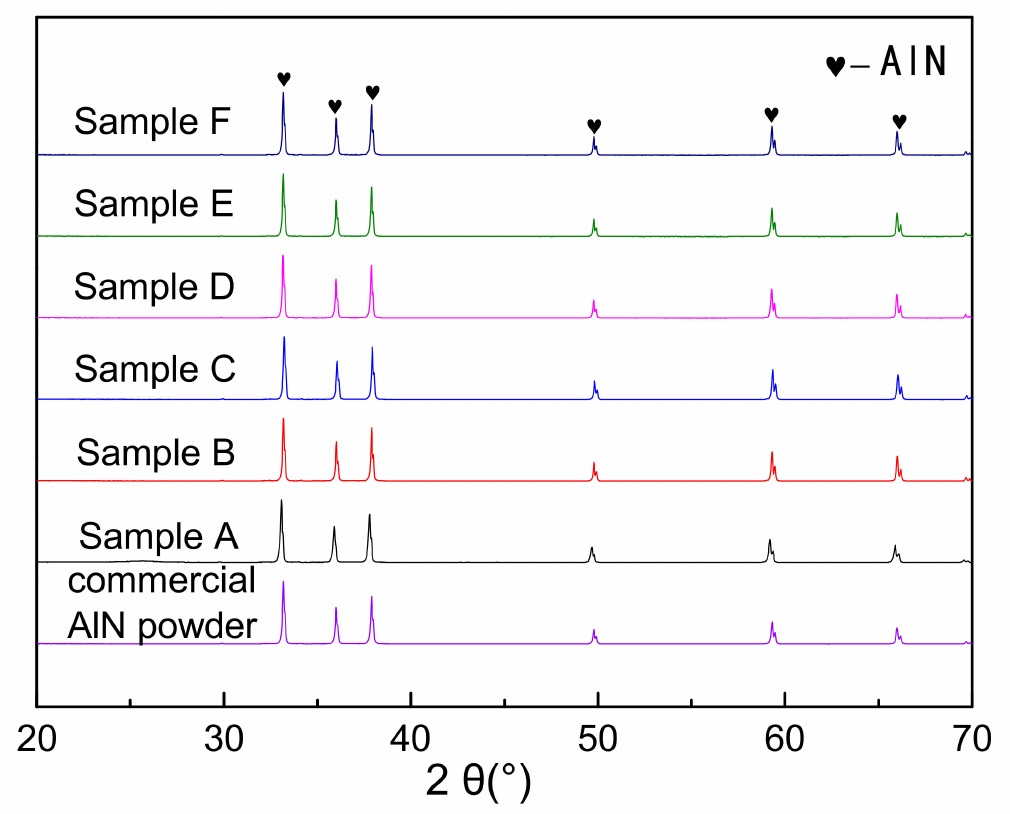
Figure 5. XRD patterns of the carbothermal reduction–nitridation (CRN) powders with different PVB additions and commercial AlN